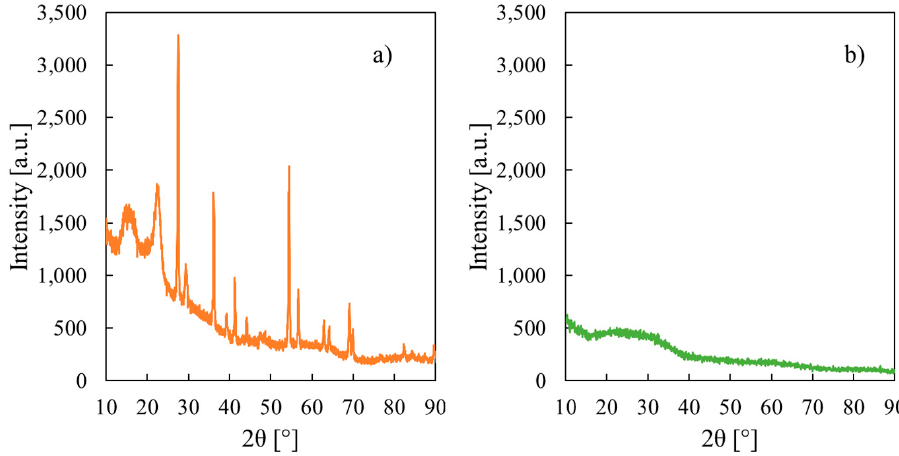
Figure 2. X-ray diffraction patterns related to CS/PTA membrane with ( a ) TiO 2 and ( b ) Al 2 O 3 particles.